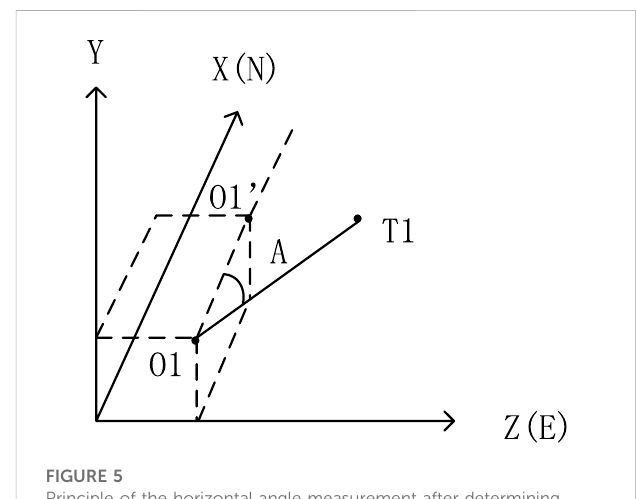
Principle of the horizontal angle measurement after determining the rear-view point under the left-handed coordinate system of the